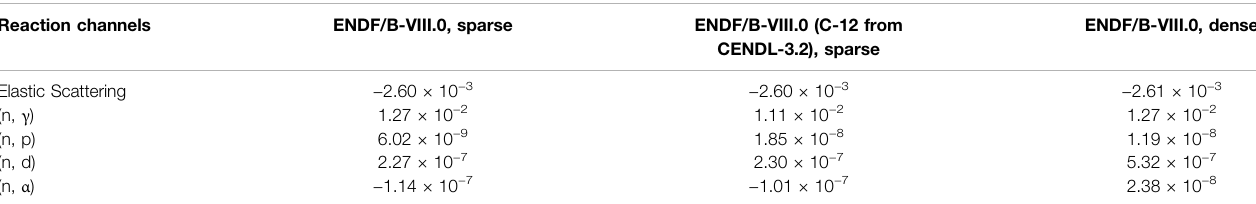
TABLE 6 | Comparison of assessed results of different cases. Reaction channels